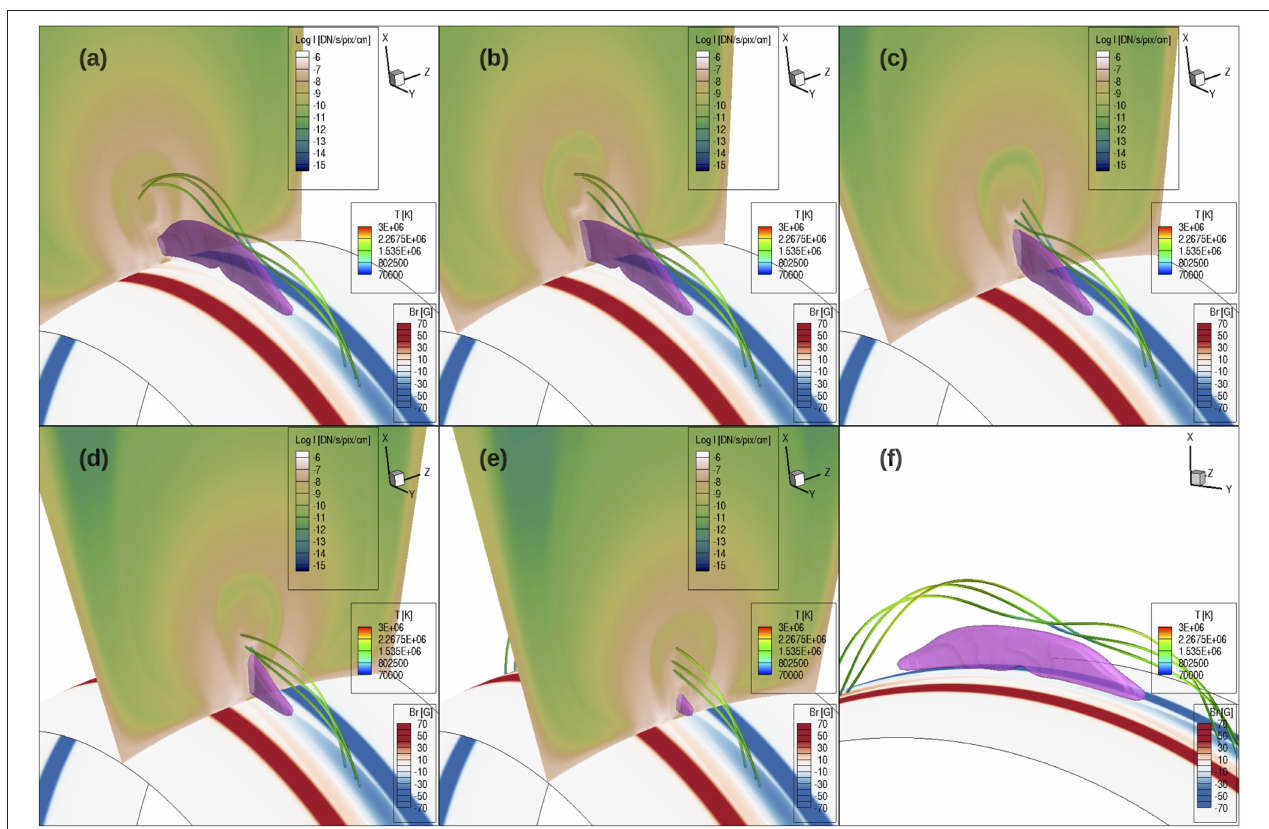
FIGURE 11 | A set of field lines threading through the region that contributes to the EUV 193 Å channel emission that produces the horn-like structure inside the cavity, together with a cross-section showing the local emission intensity in EUV 193 Å channel (the integrand n e 2 f 193 ( T ) in Equation 2) placed at different locations along the flux rope for the different panels (a–e) . (f) shows the same field lines without the cross-section and viewed from a different perspective. The field lines are colored in temperature. A pink iso-surface of temperature at T = 7.5 × 10 4 K outlines the location of the prominence condensation. The lower boundary surface is colored with the normal magnetic field strength. All the images are at the same time ( t = 13.88hr) as those in Figure 9 .